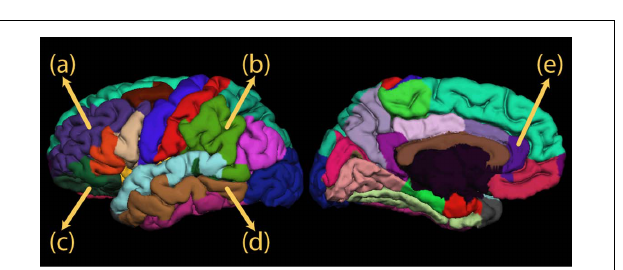
FIGURE 2 | Regions in which we found longitudinal evidence for brain structural plasticity in simultaneous language interpreters: (A) left middle frontal gyrus, (B) left supramarginal gyrus, (C) left pars orbitalis, (D) left middle temporal gyrus, (E) rostral anterior